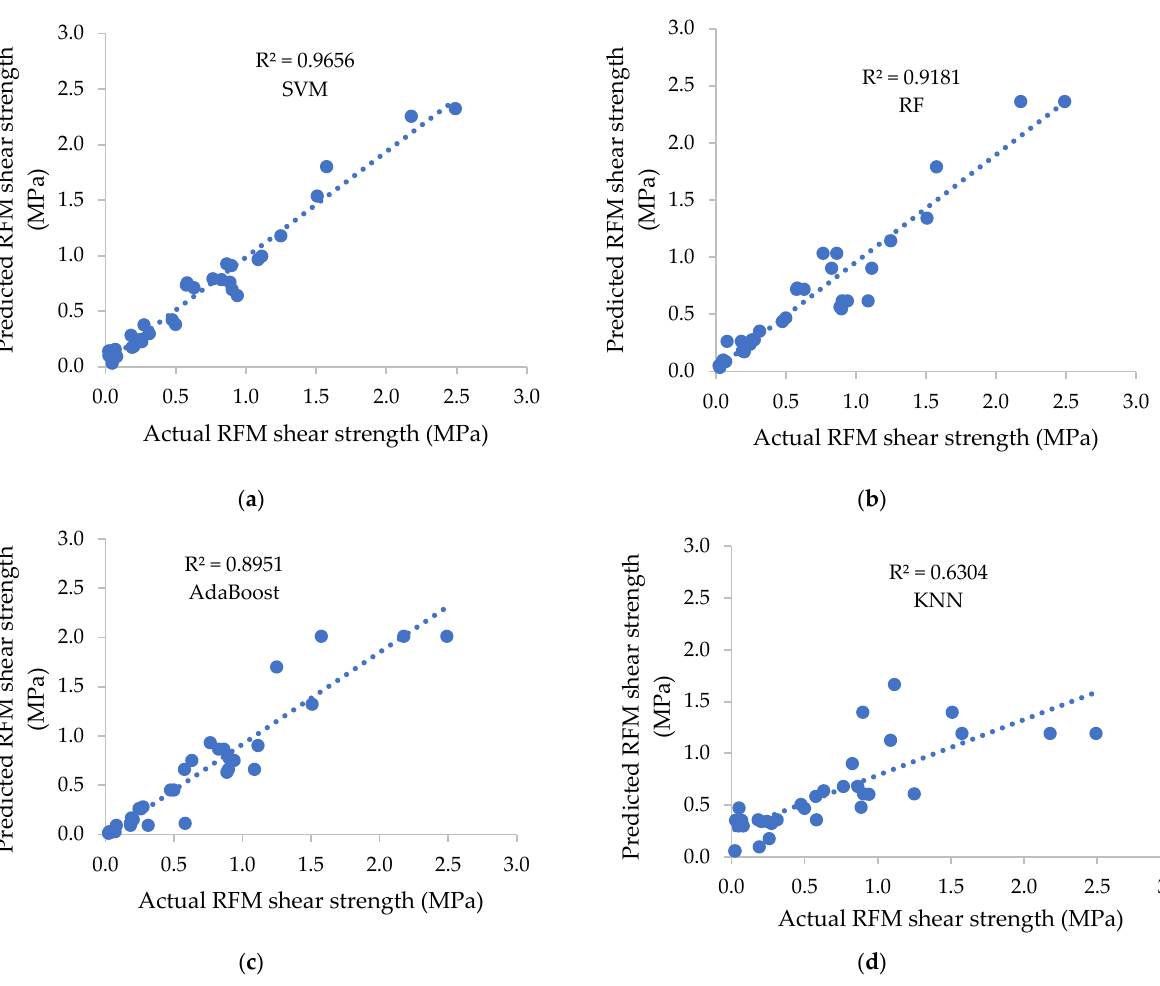
Figure 4. Scatter plots of actual vs. predicted RFM shear strength in testing stage: ( a ) SVM, ( b ) RF, ( c ) AdaBoost, and ( d ) KNN.